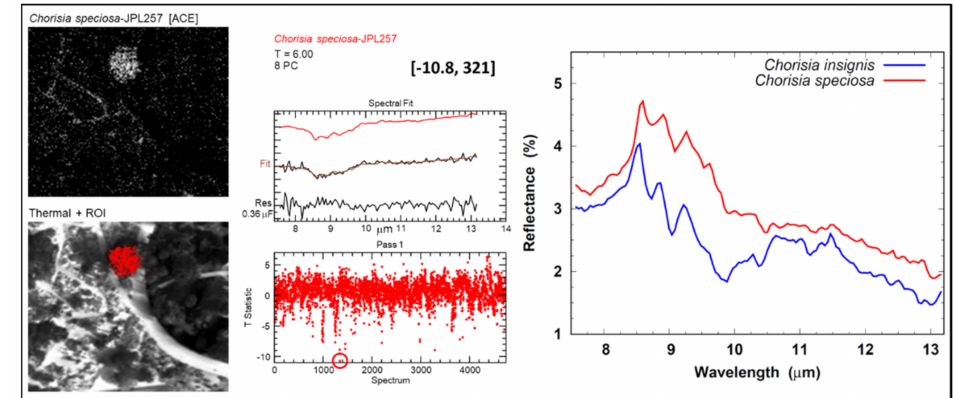
Figure 17. Mis-ID of a Chorisia insignis at the Huntington Gardens. The reference spectrum obtained from the subject tree is compared to the ID spectrum at